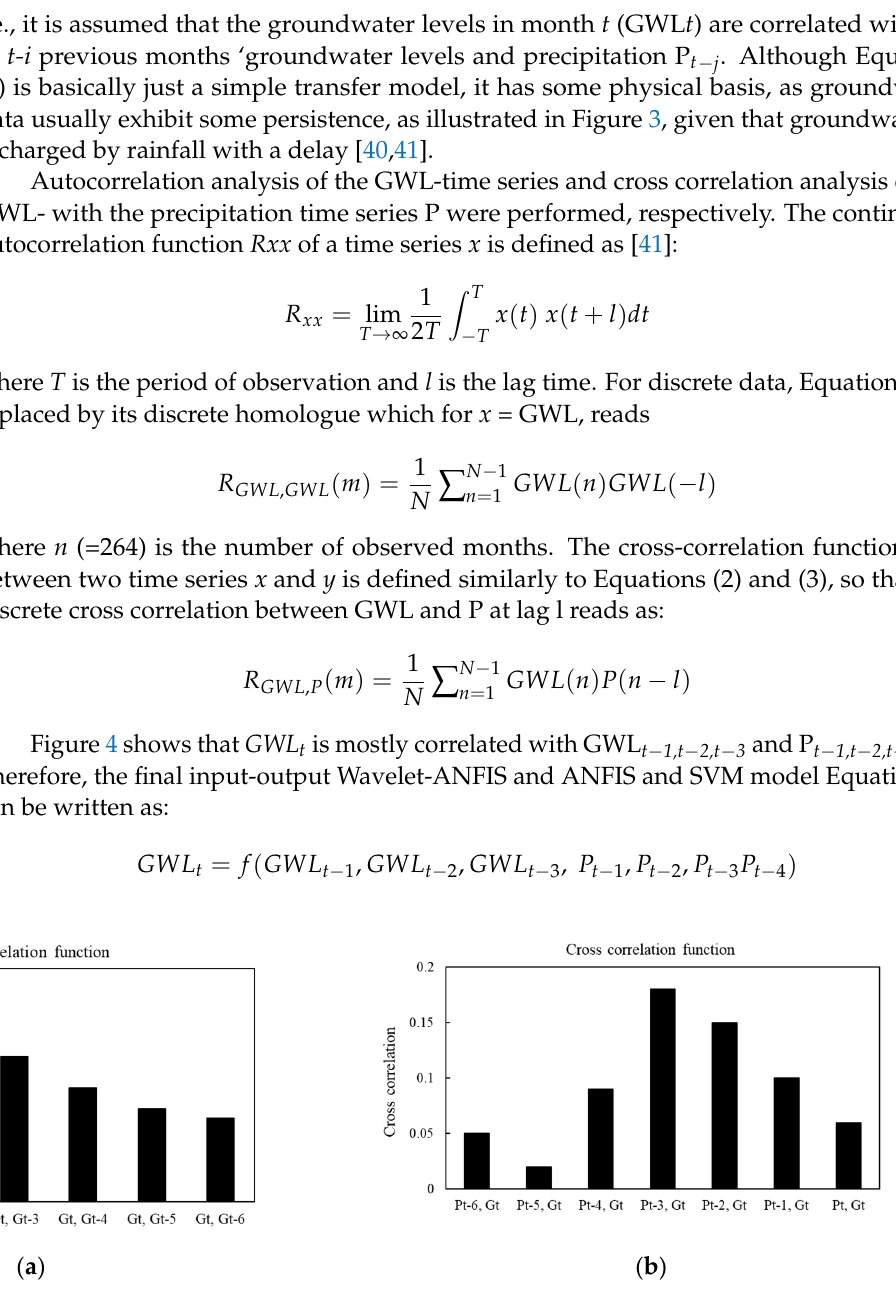
Figure 4. Autocorrelation function for GWL ( a ) and cross correlation function between GL and Precipitation ( b ).